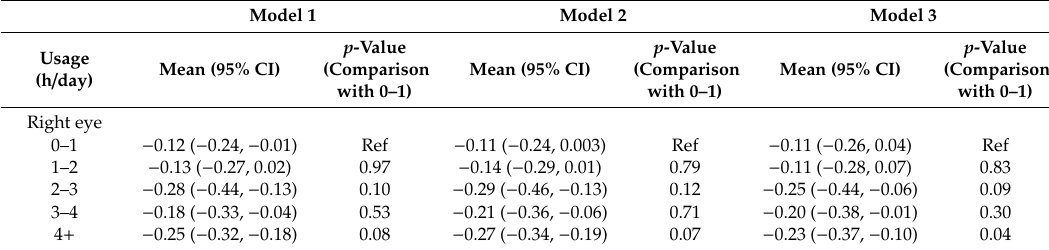
Table 3. Multivariate regression of smartphone usage (hours per day) on 1-year change in spherical equivalent refraction (SER), imputed